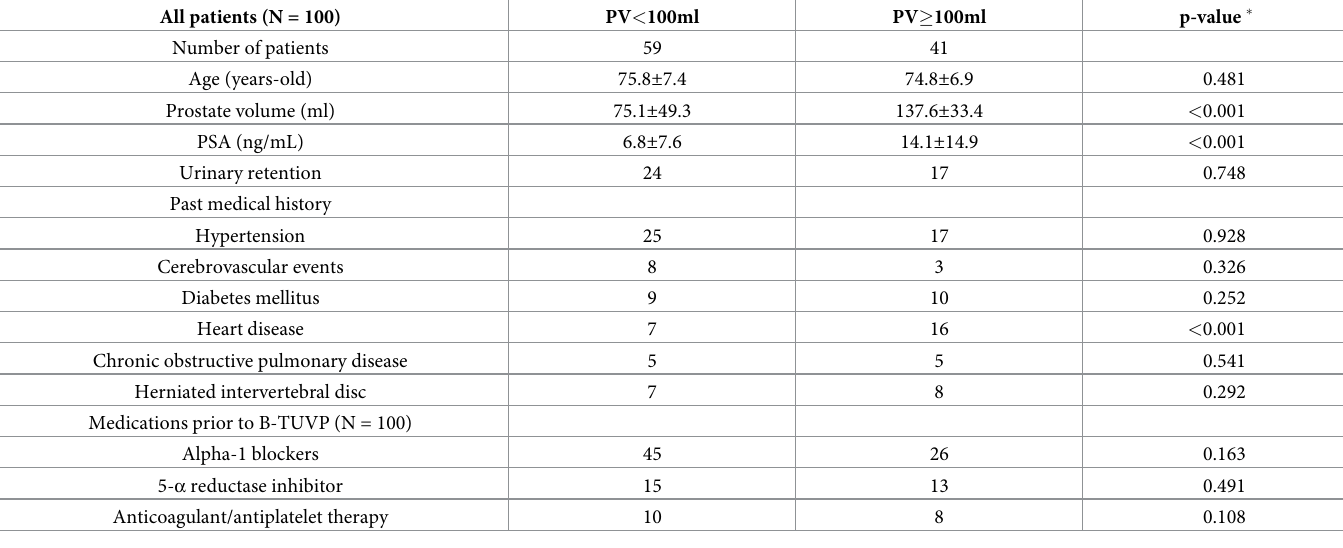
Table 1. Patients’ backgrounds.